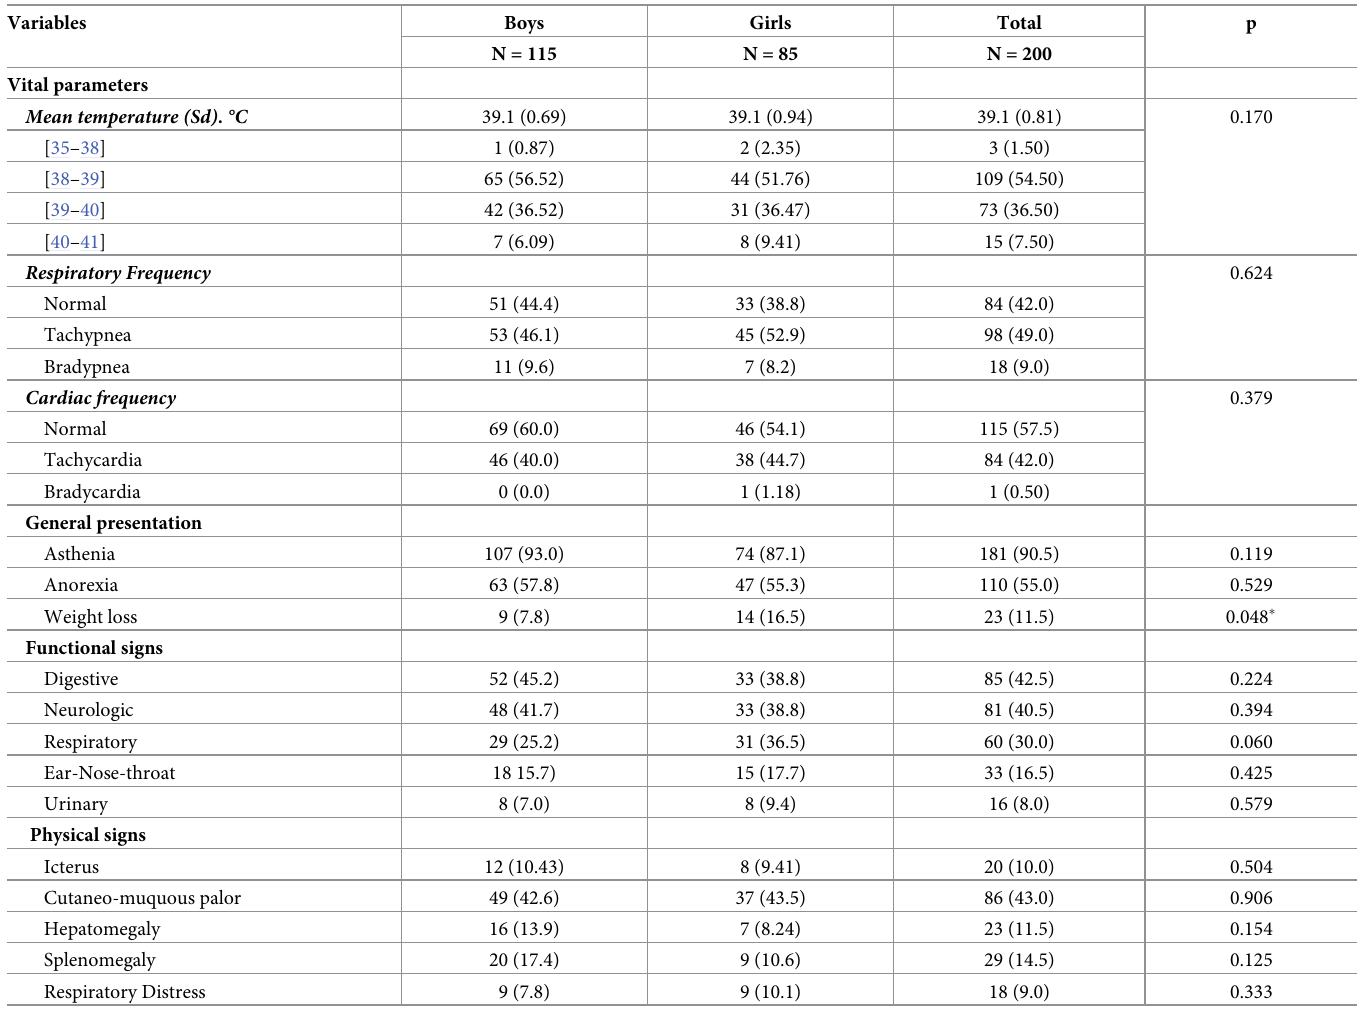
Table 1. Clinical characteristics of the study